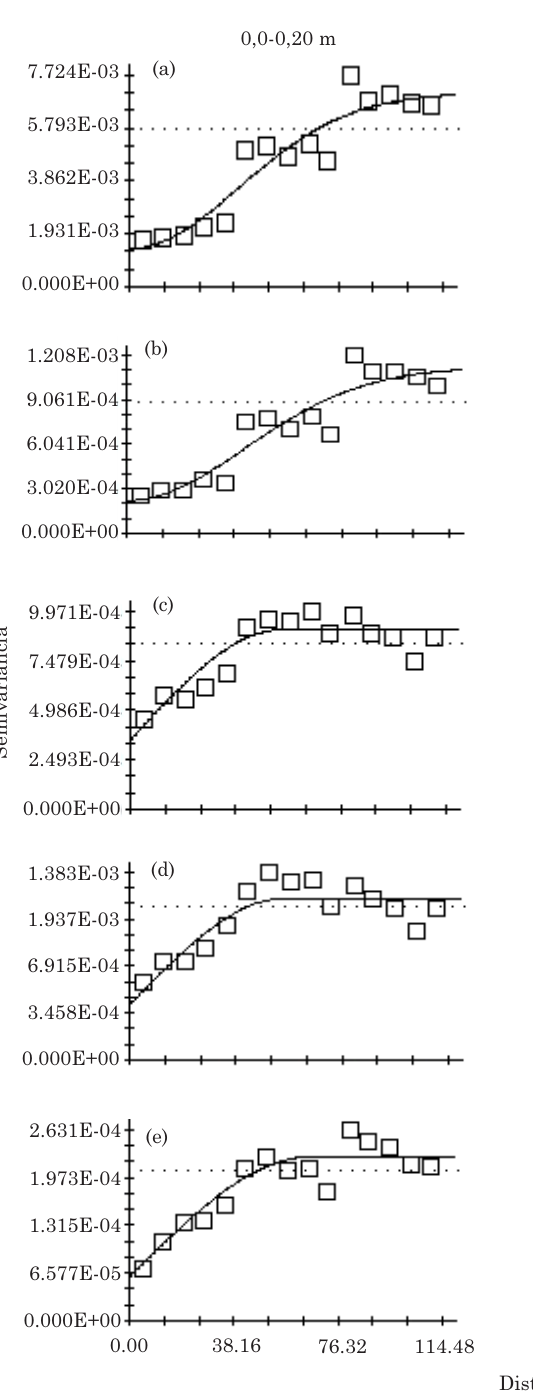
Figura 2. Semivariograma dos atributos densidade do solo (a), porosidade total (b), areia total (c), silte (d) e argila (e), nas camadas de 0,0-0,20 m e 0,20-0,40